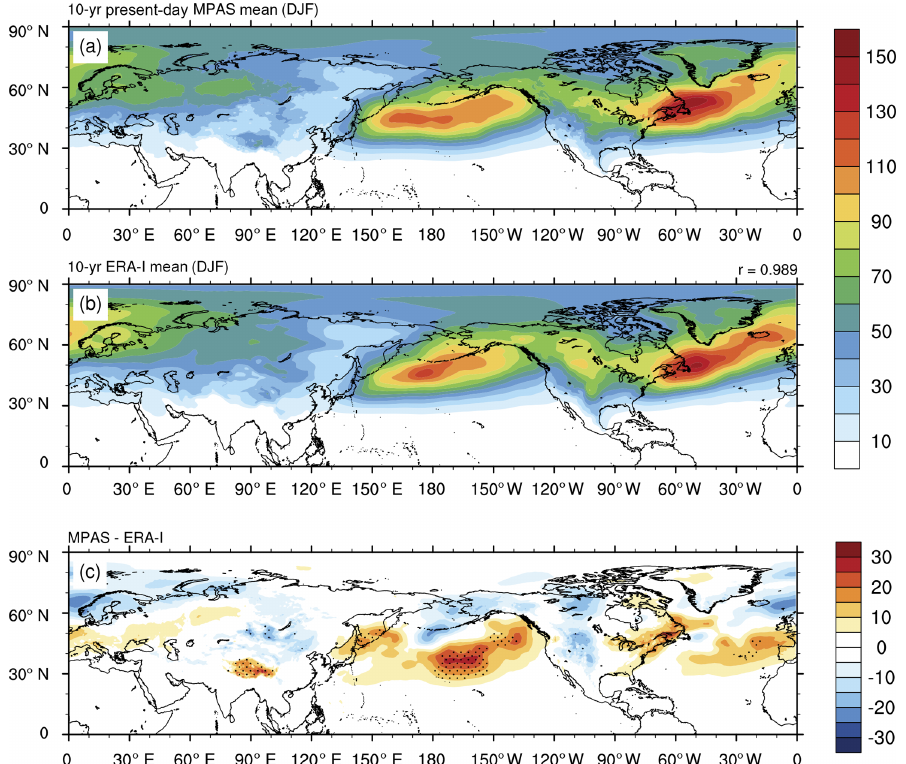
Figure 4. Average wintertime (DJF) sea-level pressure (SLP) variance (hPa 2 ) over the 10 simulation years for (a) present-day MPAS-A simulations, (b) ERA-I 10-year climatology, and (c) the model bias (MPAS-A minus ERA-I). Contours are shaded every 10hPa 2 in panels (a) and (b) and every 5hPa 2 in panel (c) . MPAS-A output was linearly interpolated to the ERA-I grid for point-to-point comparison. The pattern correlation coefficient is reported in the top right of panel (b) . Stippling in panel (c) indicates locations where the MPAS-A 10-year mean exceeds the range computed from 100 random samples of 10-year means from ERA-I by more than 5% ( ∼ 7hPa 2